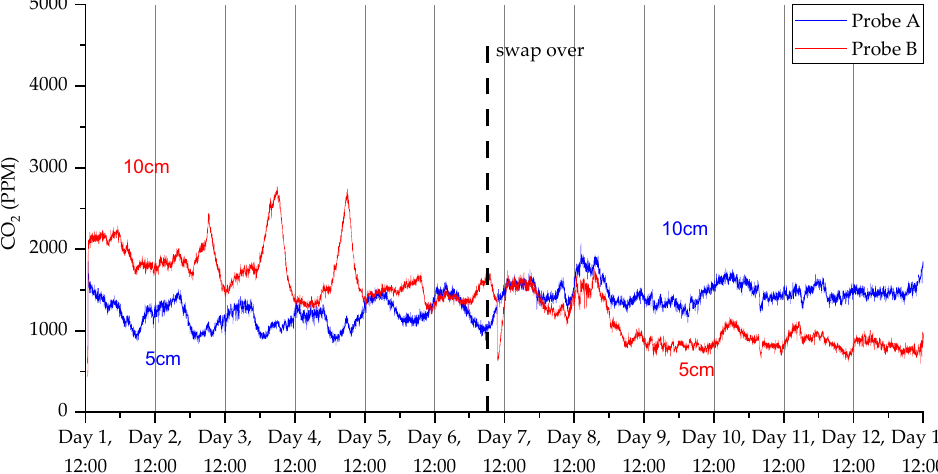
Figure 13. CO 2 measurements for the 2nd deployment in Wellesbourne campus woodland. Data collection commenced on 12 February 2022 at 12:45 (24 h time).